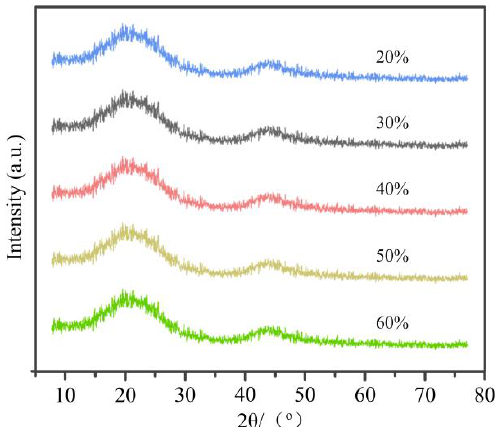
Figure 4. XRD patterns of C WCMs with different resin concentration sintering at 800